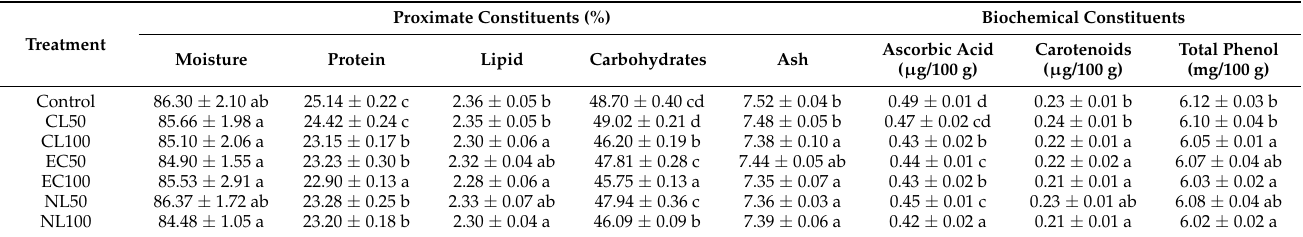
Table 3. Effect of wetland plant biomass on proximate and biochemical constituents (mean ± SD of five replicates) of P. florida